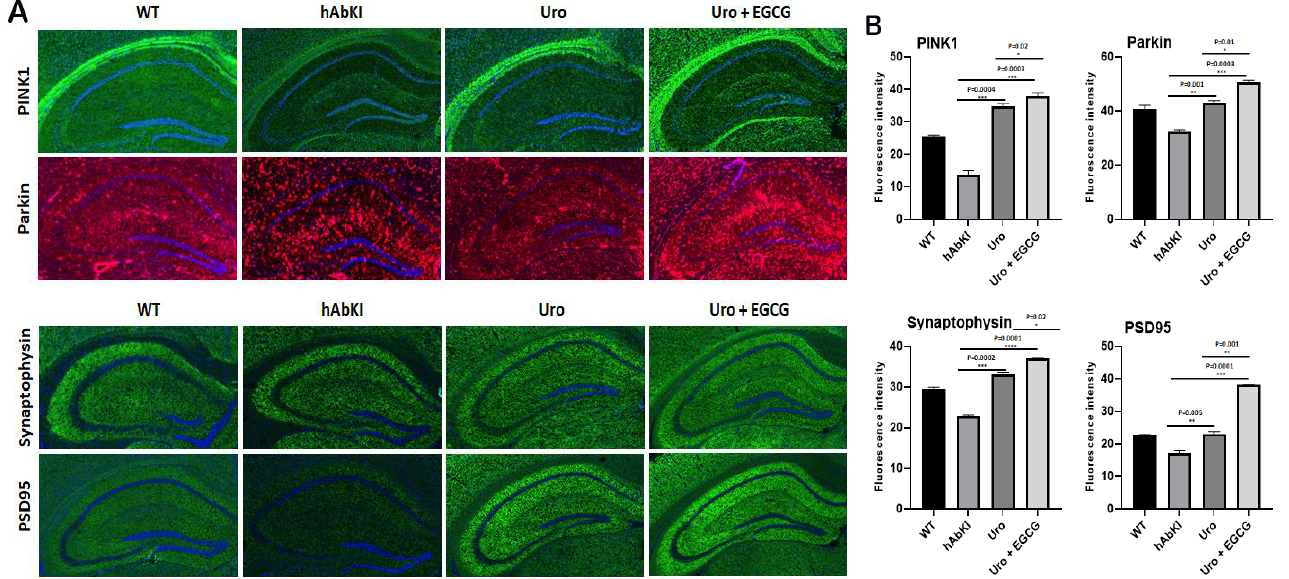
Figure 10. Immunofluorescence analysis of hippocampal synaptic proteins (synaptophysin and PSD95) and mitophagy proteins. ( A ) Immunofluorescence staining and quantitative immunofluo- rescence analysis of hAbKI mice and treated hAbKI mice with Urolithin A and EGCG. ( B ) PINK1 and Parkin levels were significantly elevated (PINK1 and Parkin in the hAbKI mice with Urolithin A and EGCG. ( A ) Representative images of immunofluorescence and ( B ) quantitative immunoflu- orescence analysis of synaptic proteins, synaptophysin and PSD95 in hAbKI mice and treated hAbKI mice with Urolithin A and EGCG. ( B ) Representative images of immunofluorescence analy- sis of synaptic proteins, synaptophysin and PSD95 proteins.